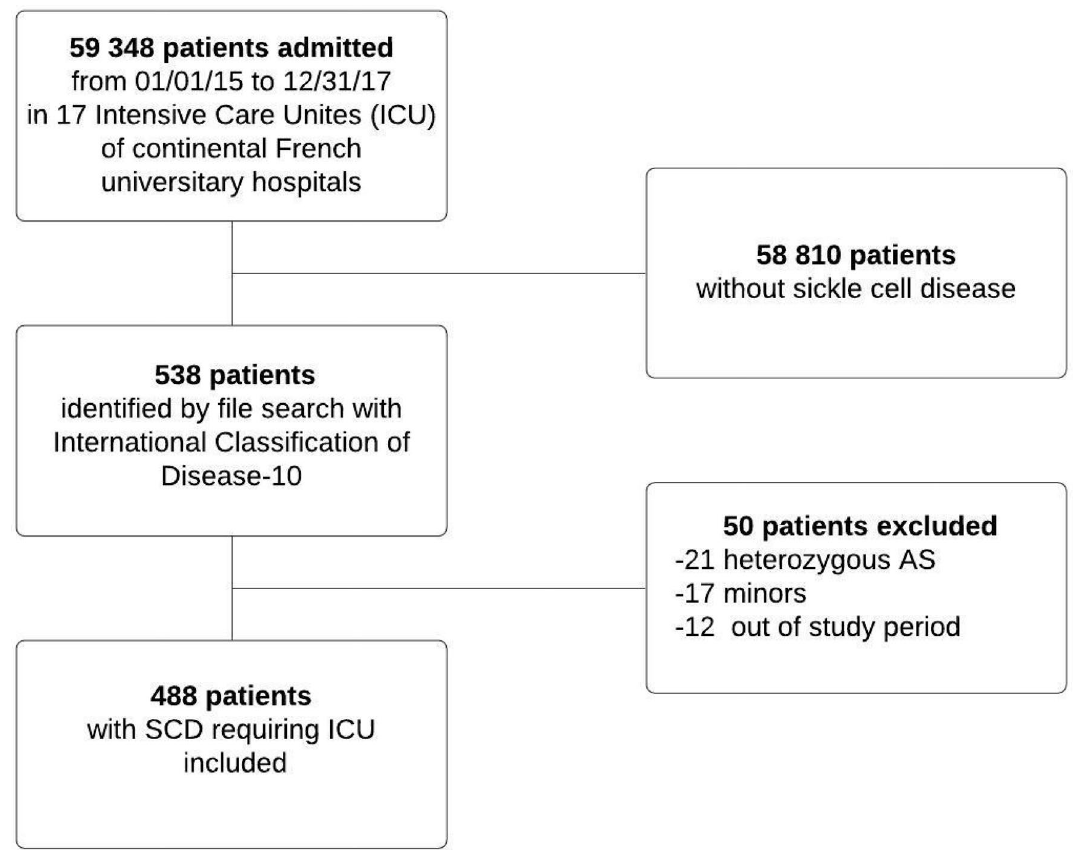
Figure 1. Patient